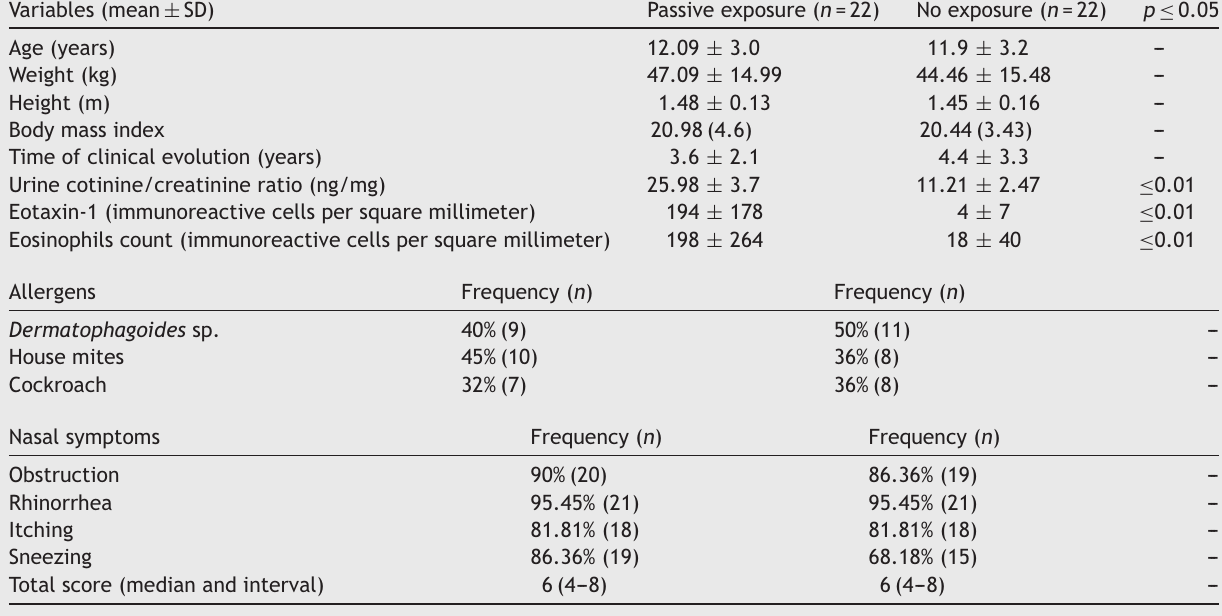
Characteristics of 44 patients with perennial allergic rhinitis: 22 with and 22 with no exposure to cigarette tobacco